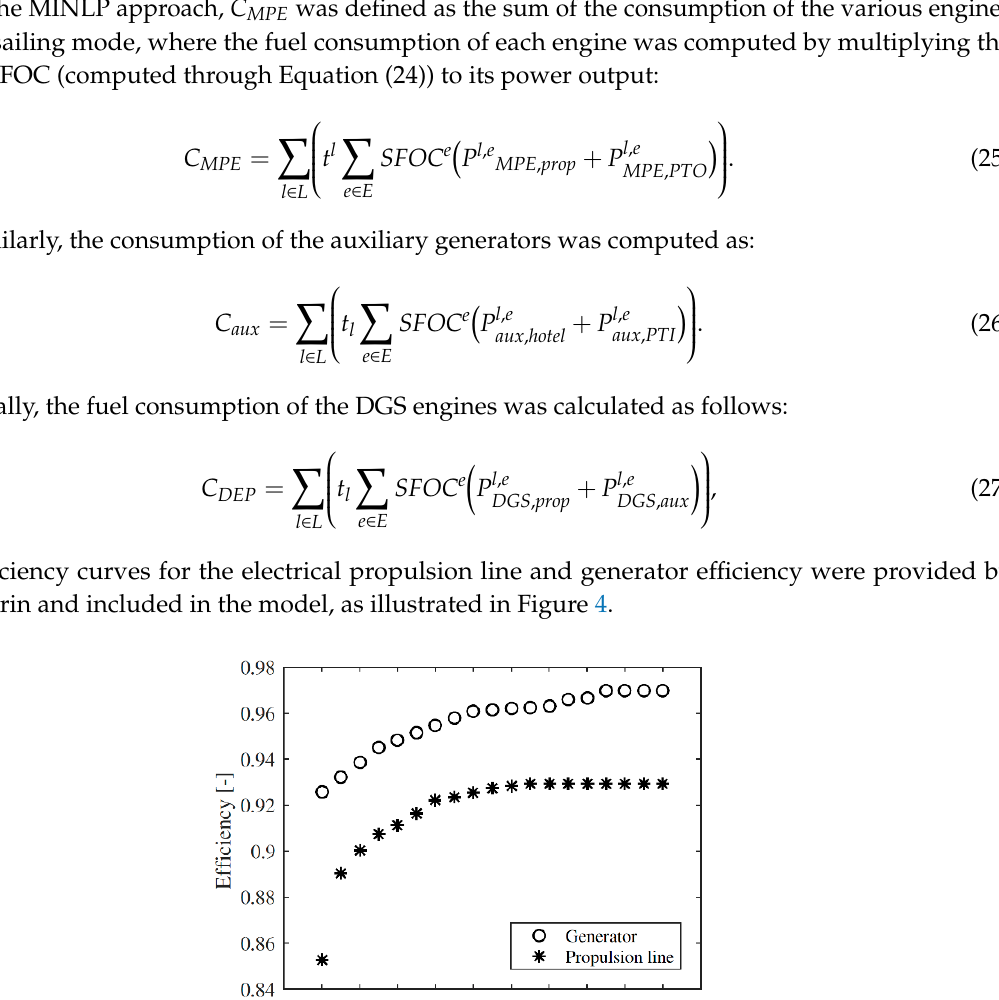
Figure 5. Mixed integer non-linear programming (MINLP) optimization routine. 2.2.4. Multi-Objective Optimization Lastly, a multi-objective optimization was setup. The optimization routine was the same as in the MINLP approach, with the addition of the overall volume of the installed engines as a second objective. The considered volume is that required for the engines themselves, but does not include the additional space required around the engines for maintenance tasks. This parameter was added as a way to identify a range of optimal solution to be screened according to the space requirements on board. The volume of the various engines was retrieved from the manufacturer’s product guides. The multi-objective optimizations were carried out using the genetic algorithm available in Matlab.